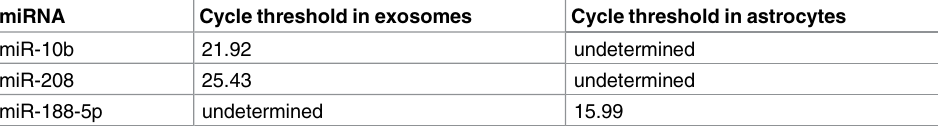
Table 3. qPCR confirmation of exosome-specific expression on miR-10b and miR-208.